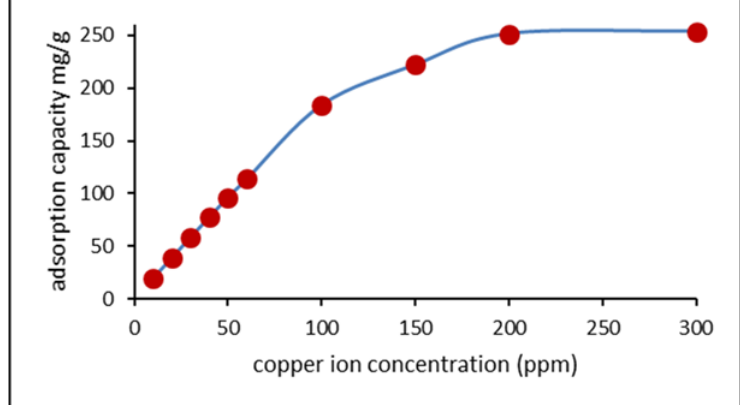
Figure 4. Concentration effect on Cu 2+ adsorption (at 25 °C, pH 6 and m = 20 mg) .